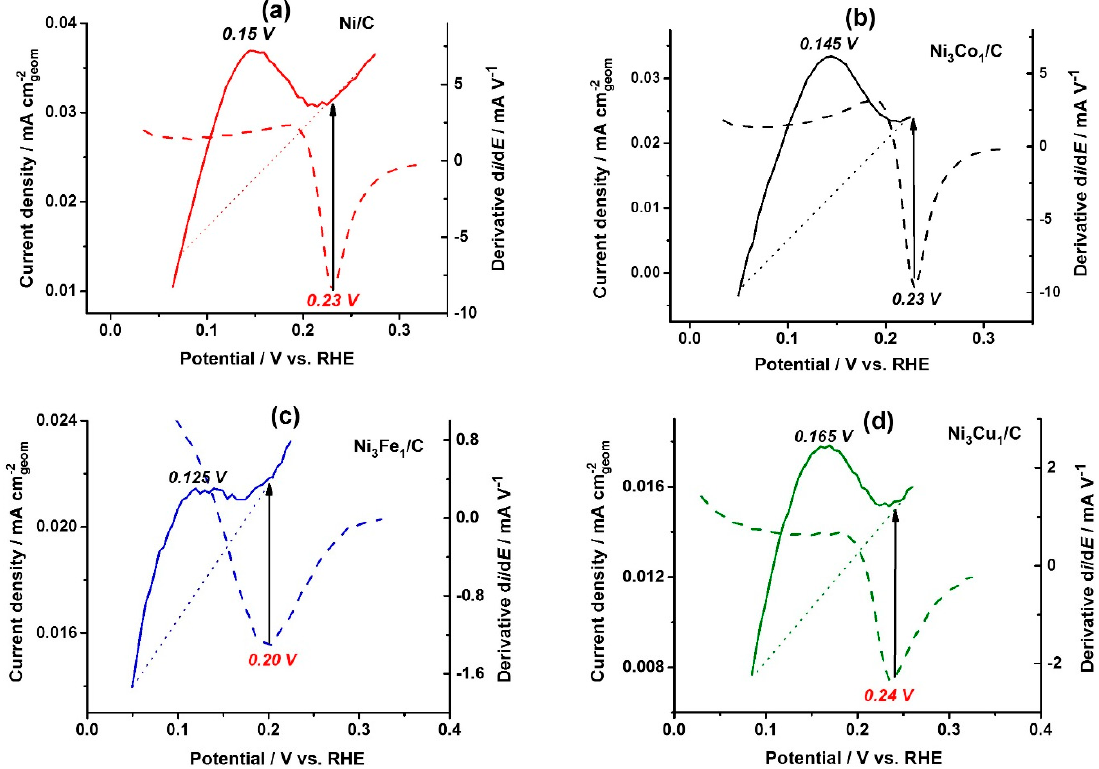
Figure 3. Linear potential stripping (solid lines) for the Ni/C ( a ), Ni 3 Co 1 /C ( b ), Ni 3 Fe 1 /C ( c ) and Ni 3 Cu 1 /C ( d ) catalysts under Ar atmosphere and the corresponding derivatives (dashed lines) of the HOR polarization curves. Numbers indicate the peak potential values.